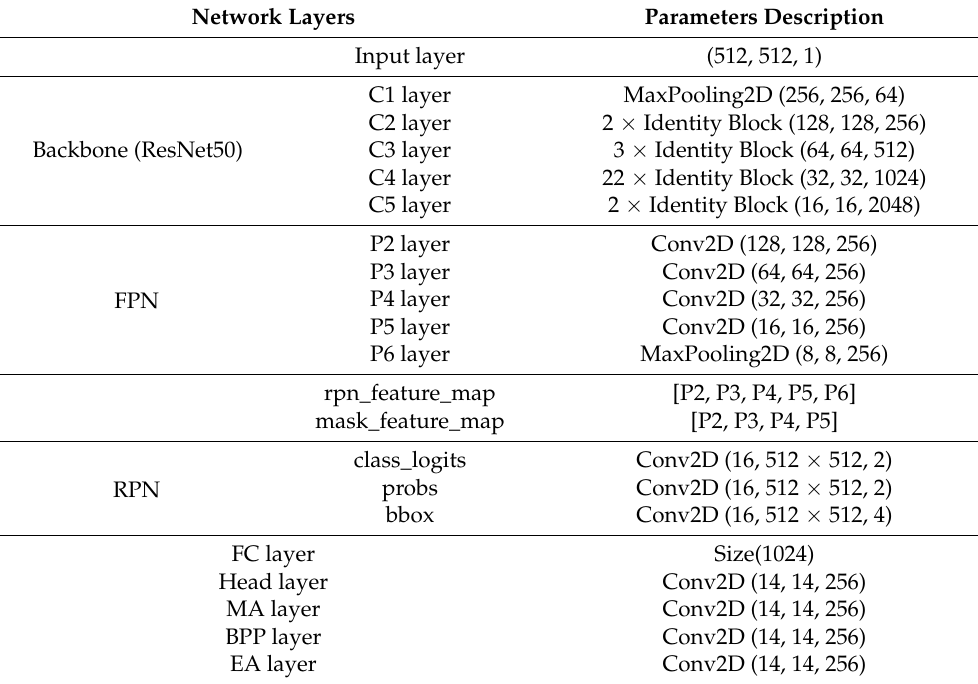
Table 1. Description of the network layer setup of our proposed SEAGNET. Network